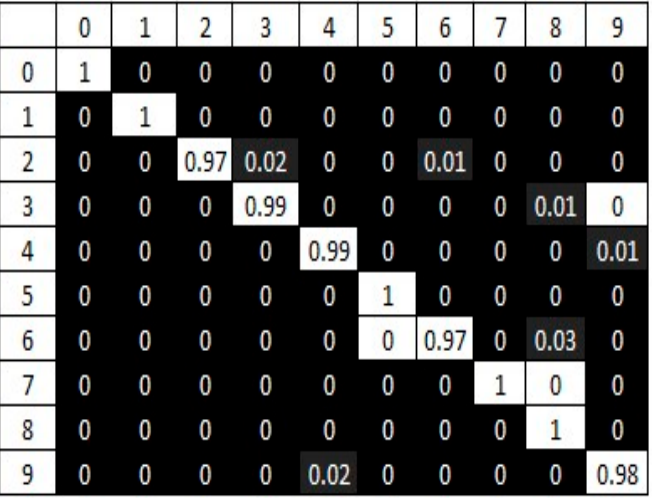
Figure 14. Confusion matrix of numbers 0 to 9.